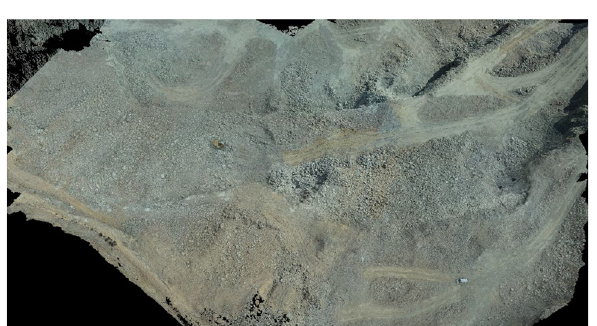
Figure 2. 3D view of granite quarry after blasting.